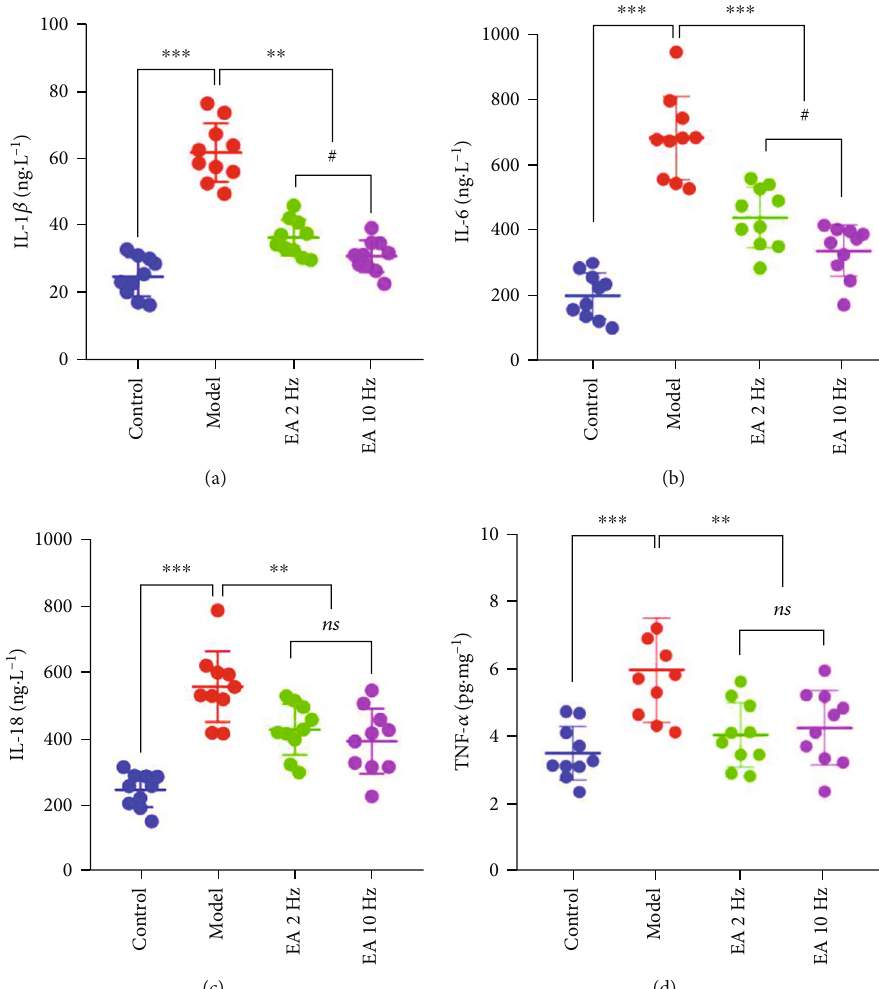
Figure 5: Electroacupuncture (EA) treatment attenuated the serum in fl ammatory factors in SAMP8 mice. (a) The level of interleukin-1 β (IL- 1 β ). (b) The level of interleukin-6 (IL-6). (c) The level of interleukin-18 (IL-18). (d) The level of tumor necrosis factor α (TNF- α ). Data are presented as the means ± standard errorof the mean ( n = 10 per group). ∗∗∗ P < 0 : 001 and ∗∗ P < 0 : 01 vs. the model group; # P < 0 : 05 vs. the 2Hz EA group. ns: not signi fi